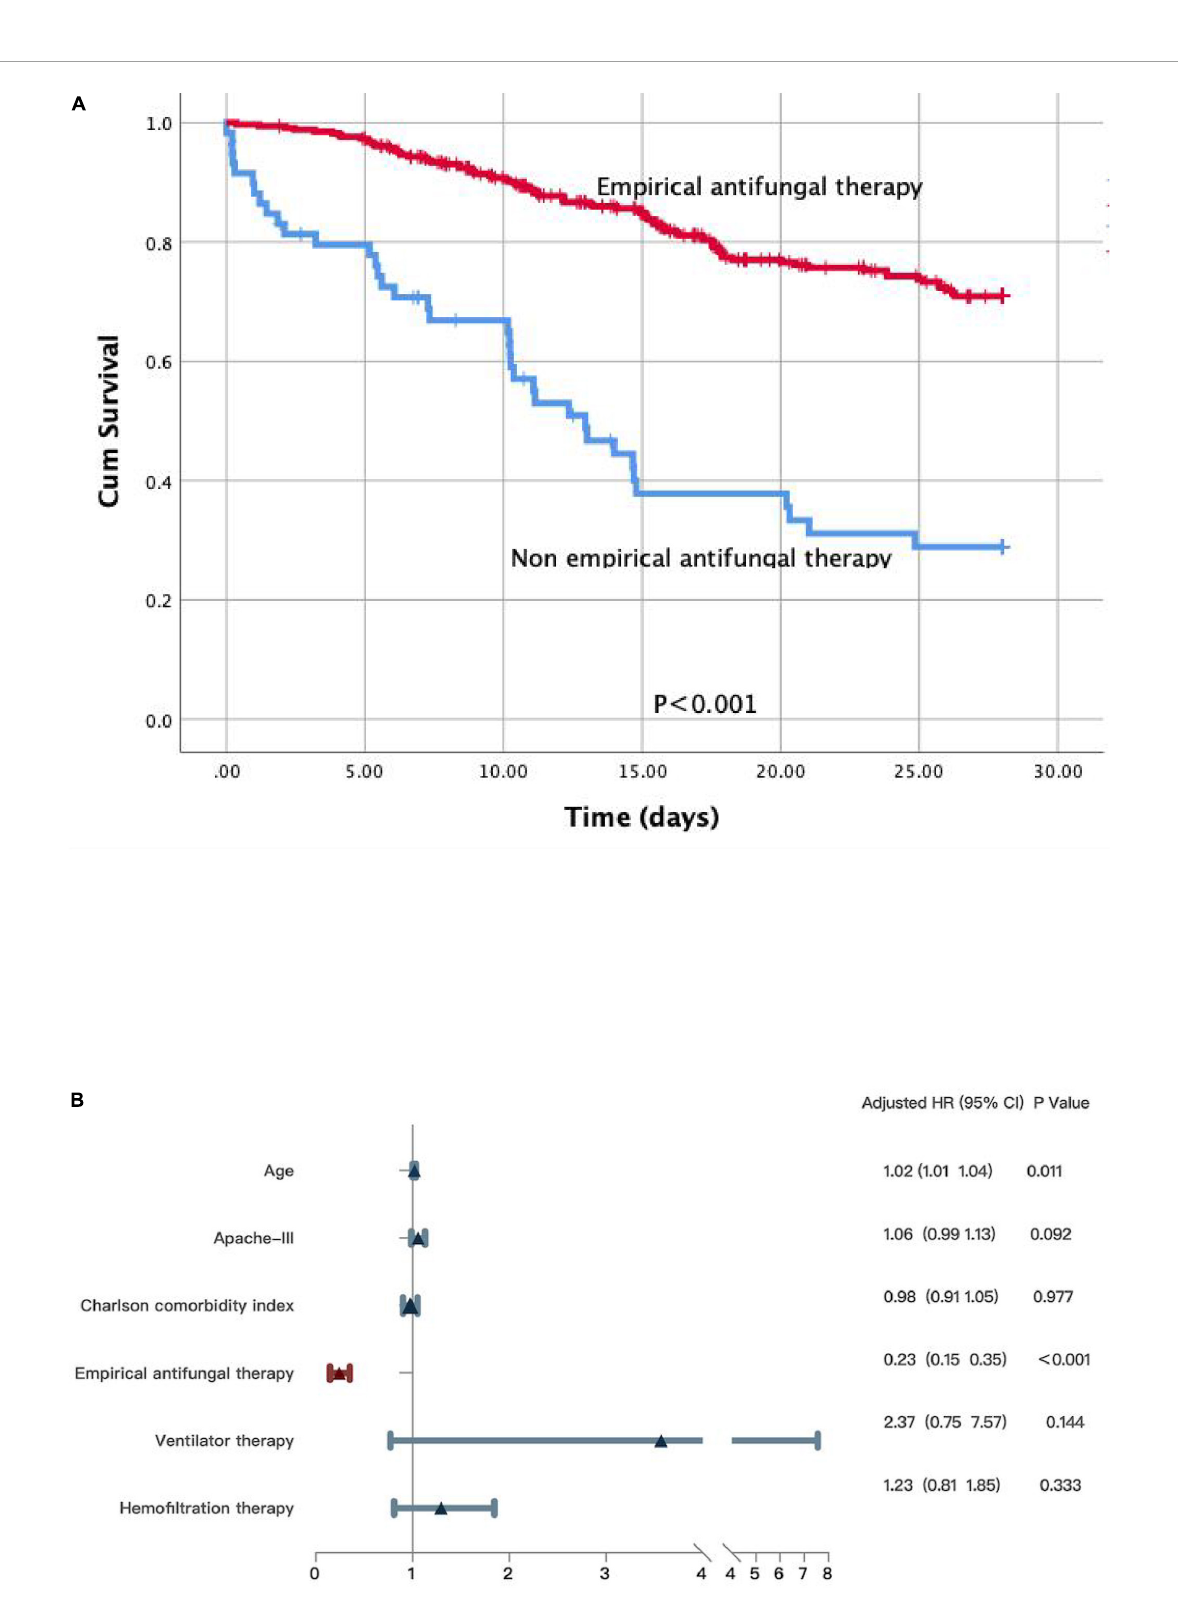
FIGURE4 (A) A Kaplan-Meier survival analysis and a log-rank test on the subgroup patients with fungus positive in blood culture. (B) Multivariate Cox regression analyses for patients with fungus positive in blood